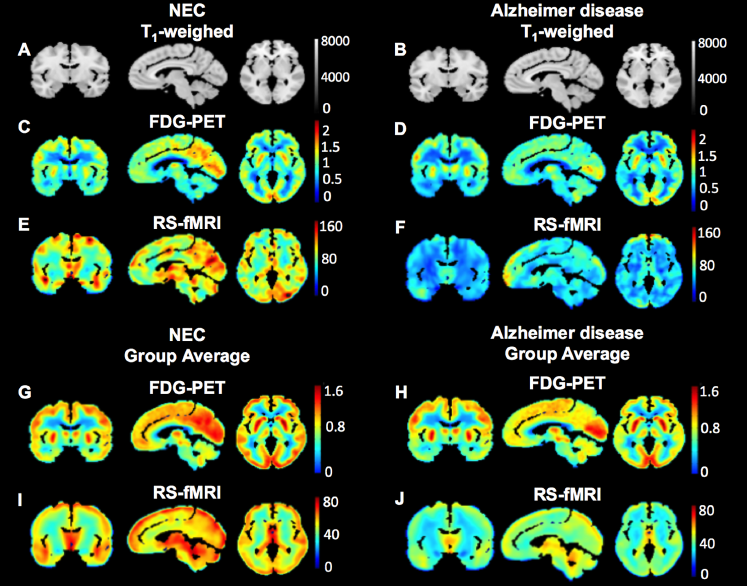
Fig 3. Brain activity and glucose metabolism maps. MNI-152 T 1 -weightedanatomicalimages in coronal, sagittal, and axial orientations (A, B). Corresponding FDG-PET SUVR images of glucosemetabolismfrom a healthyelderly subject, and healthyelderly group averaged(C, G); a patient with Alzheimerdisease,and Alzheimer diseasegroup averaged(D, H). Brain activity maps obtainedusing RS-fMRI in the same healthy elderly subject, and healthy elderly group averaged (E, I) and patient with Alzheimerdisease,and Alzheimer diseasegroup averaged(F,